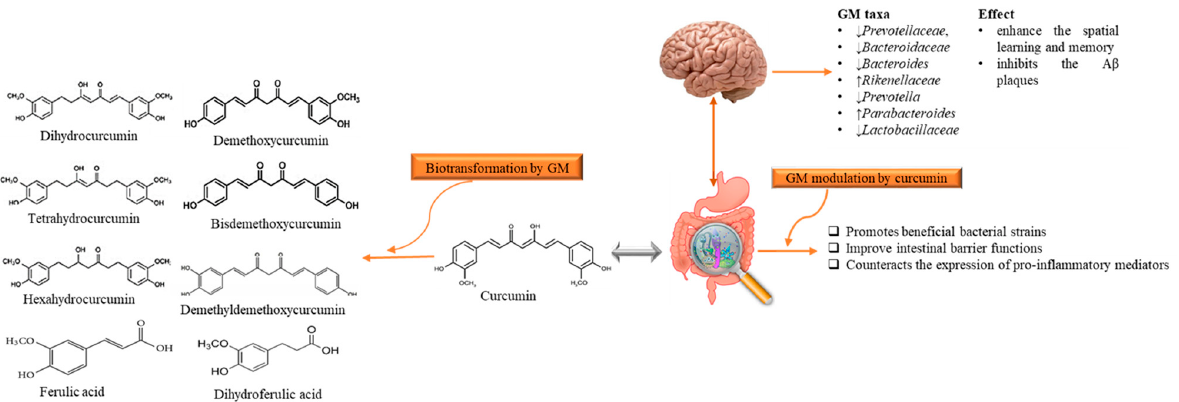
Figure 3. The reciprocal interaction between curcumin and Gut microbiota. Biotransformation of curcumin occurs due to gut microbiota that converts it into several metabolites through pathways like demethylation, reduction, acetylation, hydroxylation, and demethoxylation. These metabolites through gut-brain axis show antioxidant, anti-inflammatory, and neuroprotective effects. While, gut microbiota modulation alters the microbial abundance, diversity and composition, which also exert health benefits in Alzheimer disease-induced rats, indirectly. GM: gut microbiota .